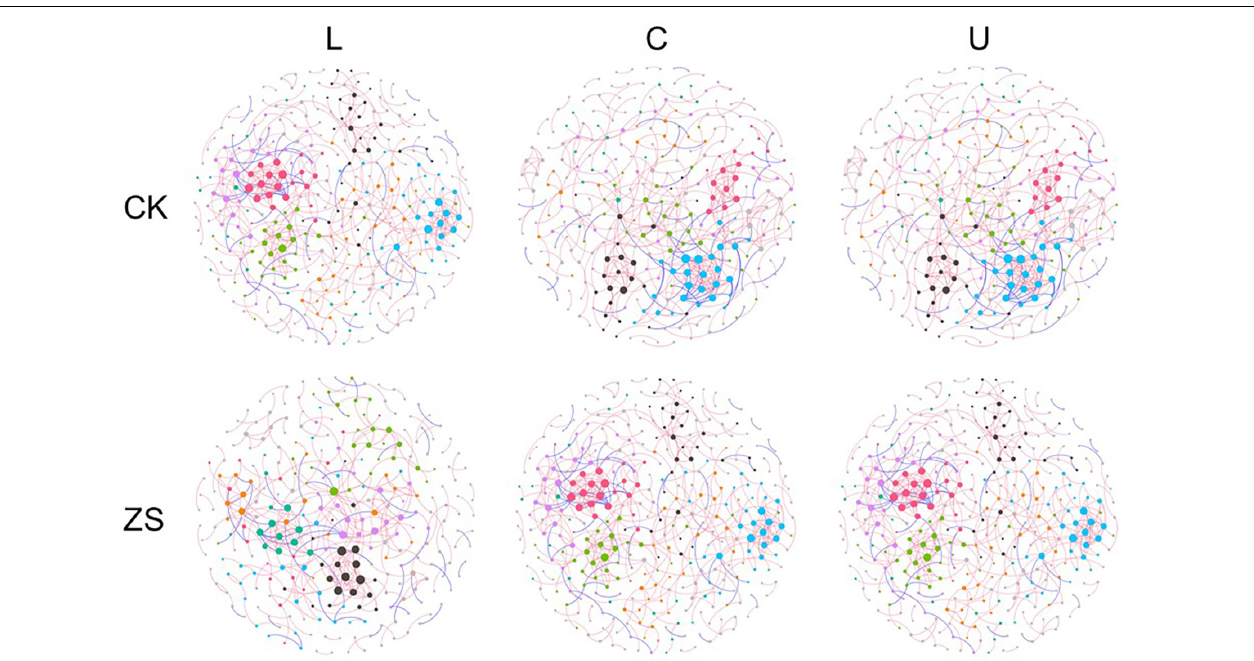
FIGURE 4 | Networks of the endophytic fungal community in ordinary (CK) and nornicotine-enriched (ZS) tobacco leaves at lower (L), center (C), and upper (U) plant sections. Positive and negative links are colored red and blue, respectively. Nodes clustered to the same module in a network are indicated by the same color; however, the colors among networks are not